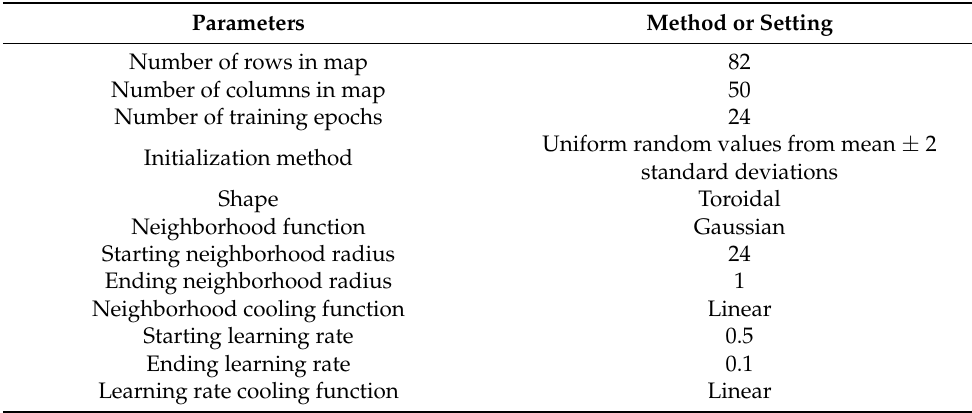
Table 5. Parameters used in the ESOM